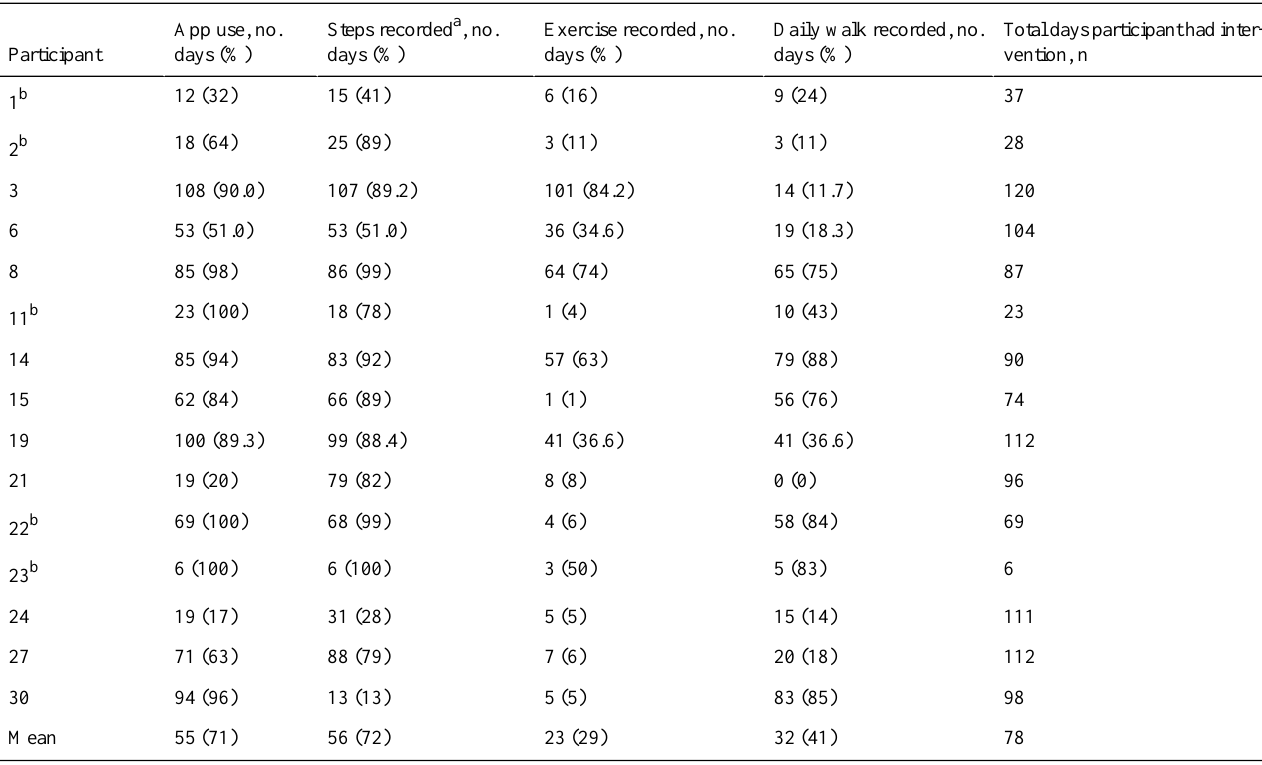
Table 5. Individual participants’use of different features of the SMART-COPD app.